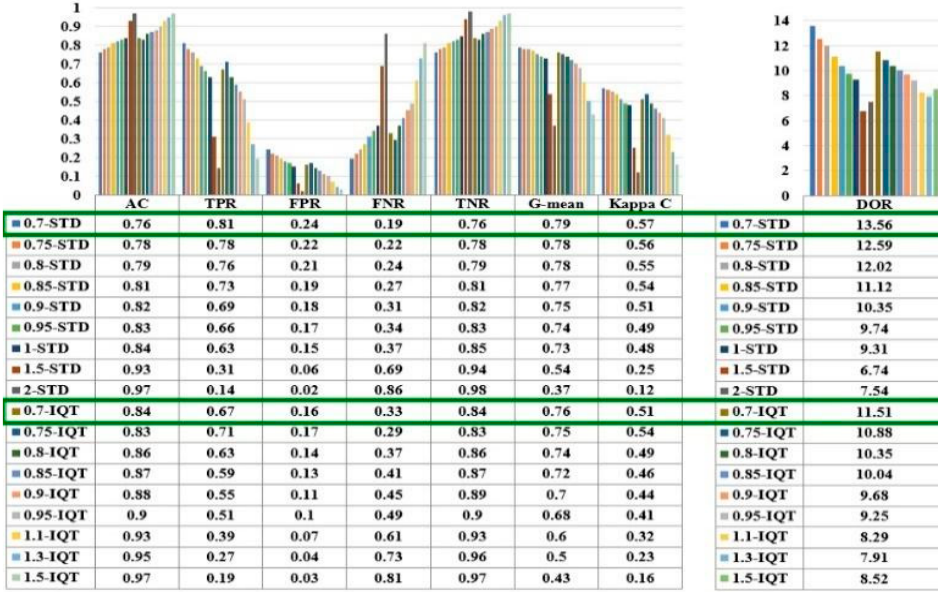
Figure 6. The full confusion matrix parameters and ACC and DOR FoM for AQUA/MODIS LST anomalies with all magnitudes for the STD and IQT methods and ‘C’ values.